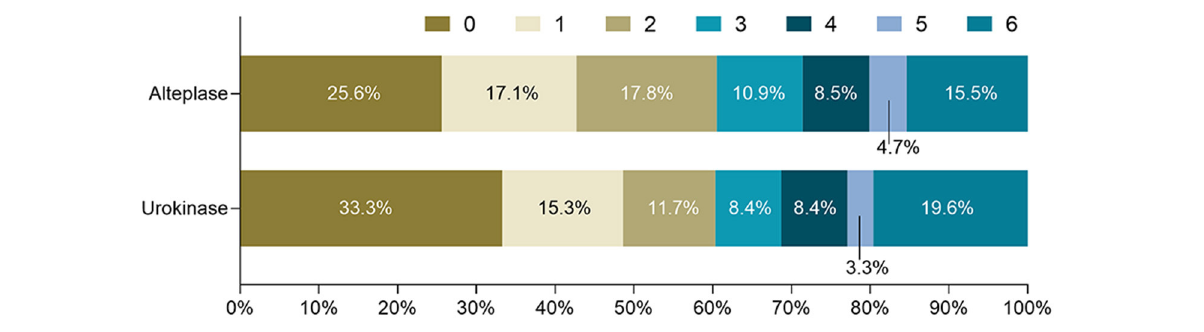
FIGURE 1 | Distribution of mRS scores at 3 months by thrombolytic drug. mRS, modified Rankin Scale.